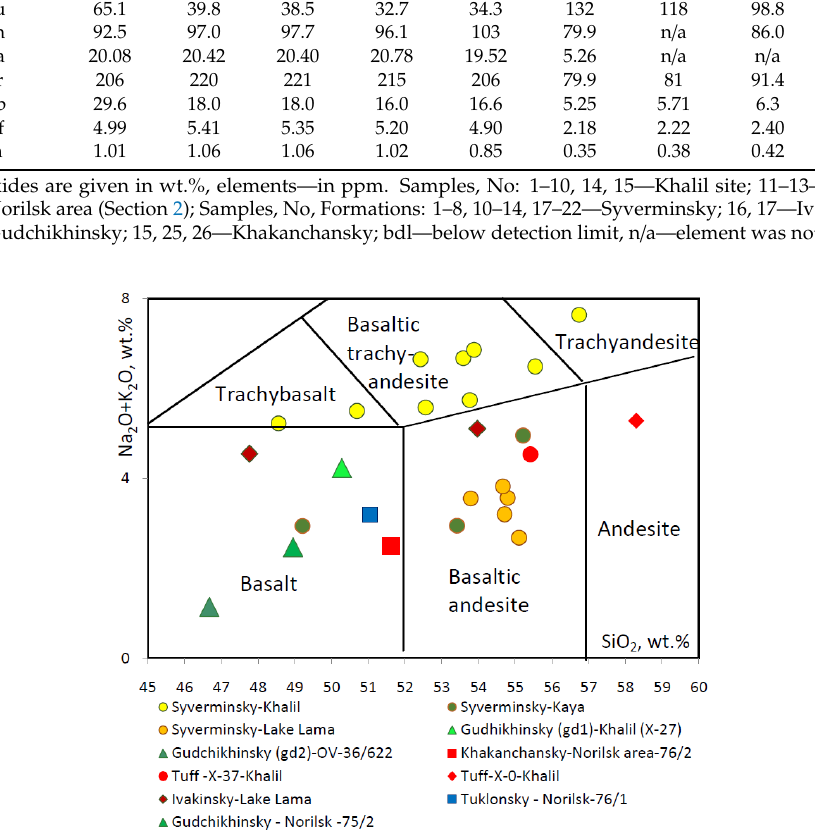
Figure 9. Diagram SiO 2 –Na 2 O+K 2 O [59] for volcanic rocks of the NW Siberian Traps province. Yellow, light brown and brown circles are rocks of the Syverminsky formation from different areas (Kylyumber–Khalil and Kaya sites, Norilsk–Lake Lama, respectively). They show a wide range of compositions belonging to basalt, basaltic andesite, trachybasalt, basaltic trachyandesite